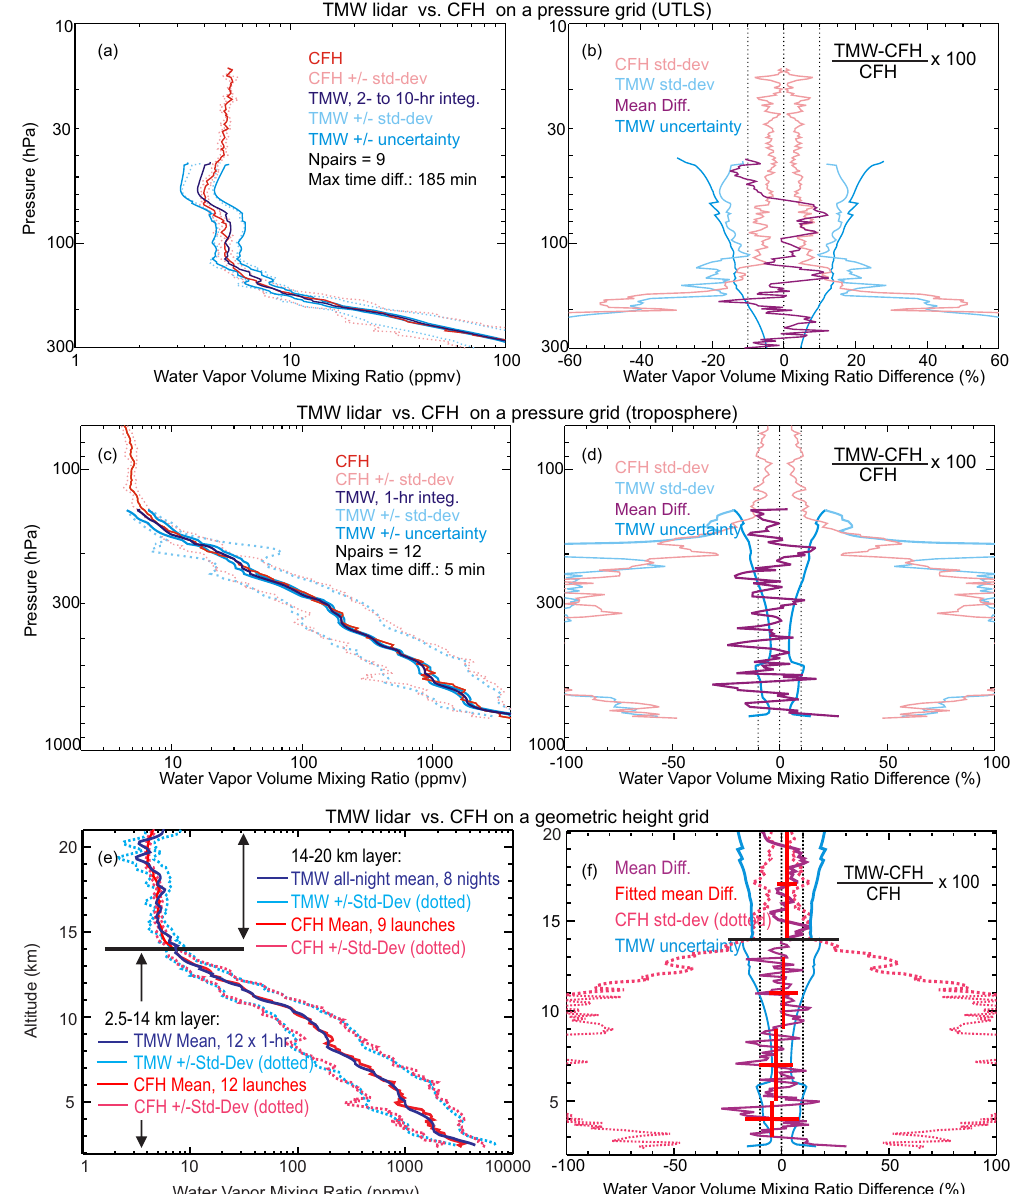
Fig. 15. Comparison of the MOHAVE-2009 campaign-averaged mixing ratio profiles (left) calculated from all coincident profiles measured by the TMW lidar and the CFH, and their difference (right). Top row (a–b) : UTLS on a pressure grid; middle row (c–d) : troposphere on a pressure grid; bottom row (e–f) : troposphere and lower stratosphere on a geometric height grid. See text and figure for details on the coincidence